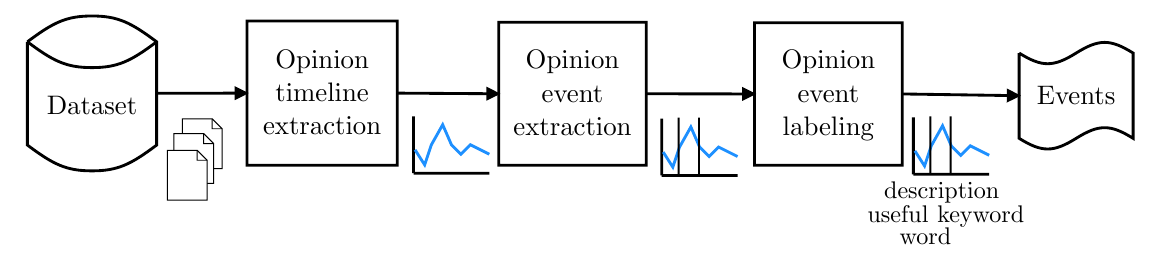
Figure 4. Architecture of the